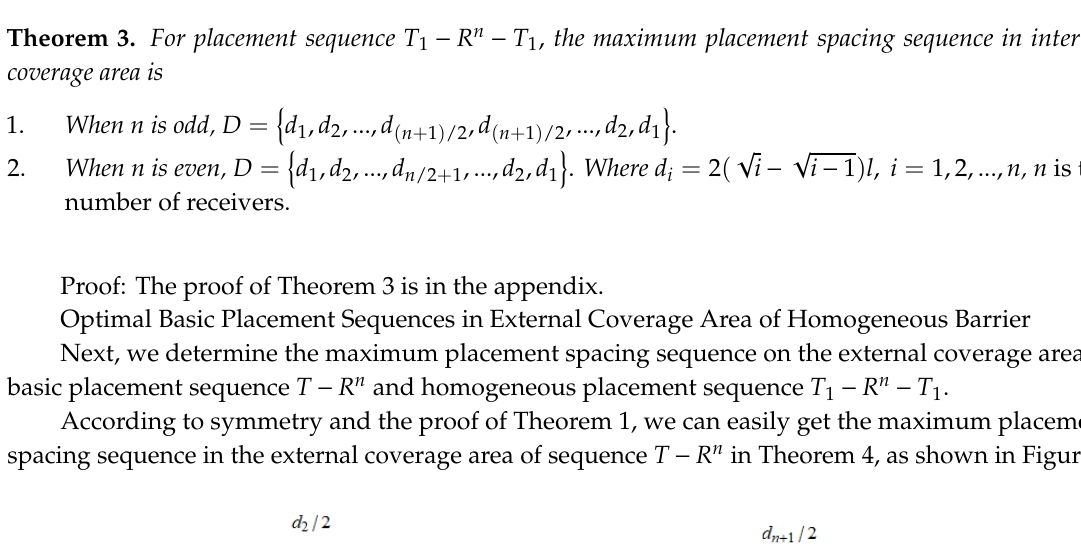
Figure 6. The maximum placement spacing sequence in internal coverage area of sequence T 1 − R n − T 1 .